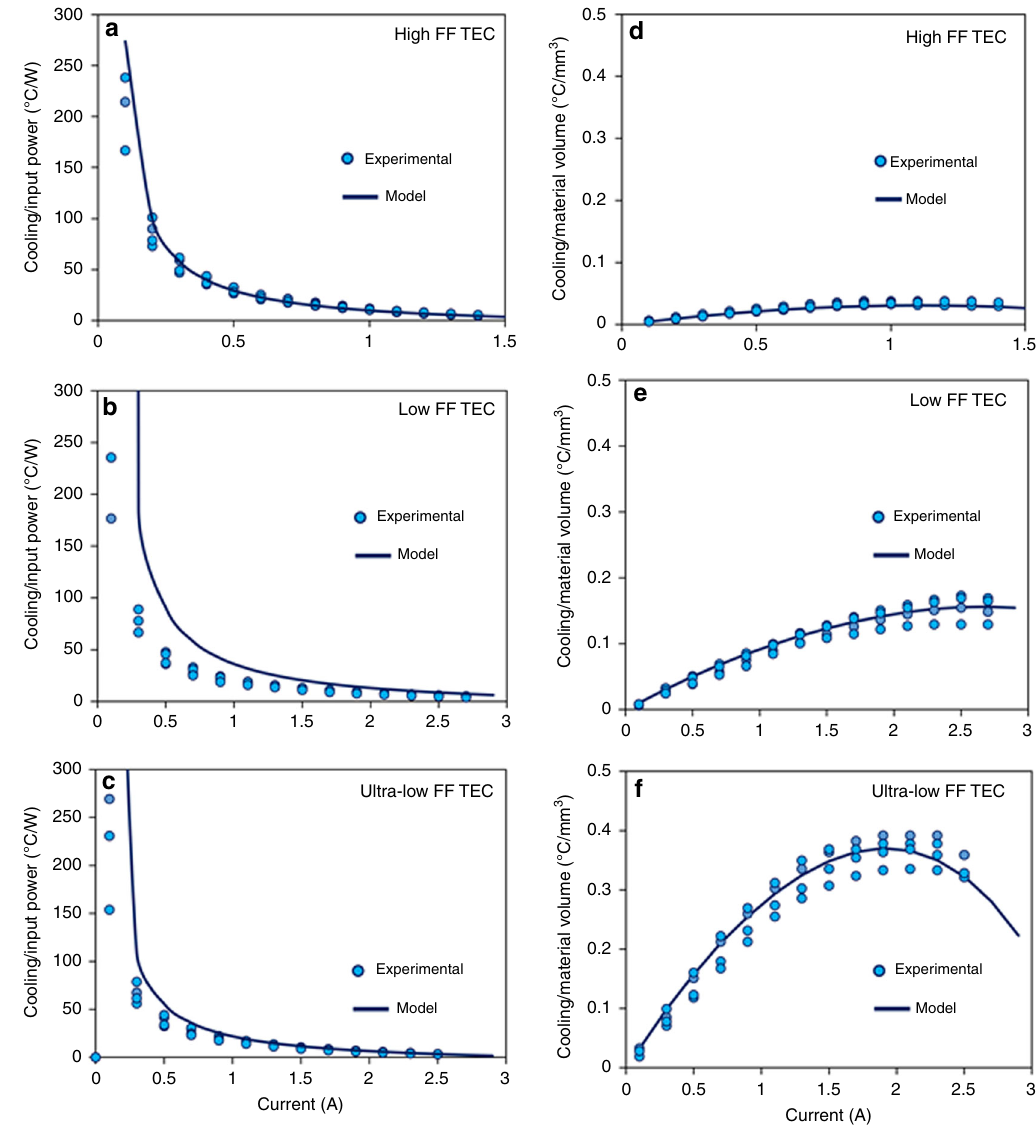
Fig. 7 Cooling over electric power and cooling over material volume. a – c For a fi xed electric current, cooling per unit input electric power is highest for the low-FF TEC followed by the ultra-low FF TEC and the high FF TEC. d – f Under optimal electric current, the cooling over TE material volume is highest for the ultra-low FF TEC, followed by the low-FF TEC and the high-FF TEC. Circles illustrate the experimental data, whereas solid lines show the modeling